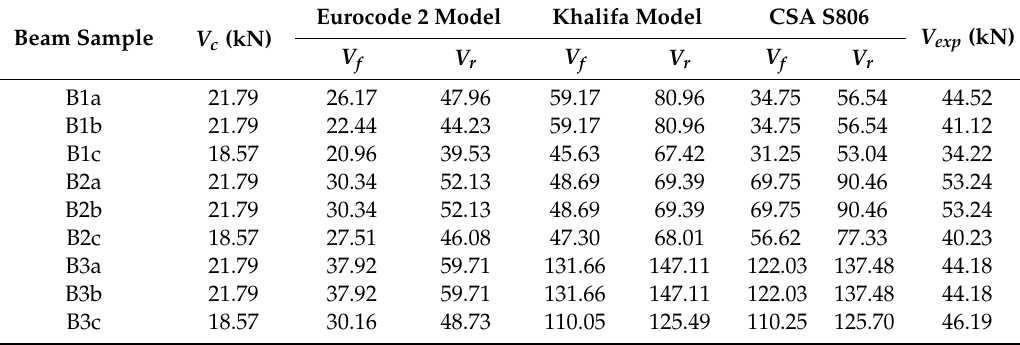
Table 2. Comparison of theoretical and experimental shear capacity of tested